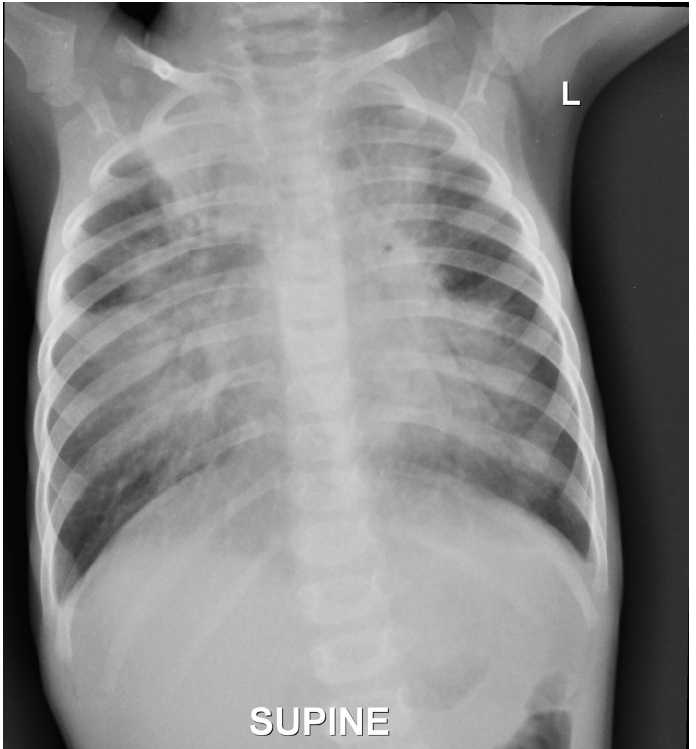
Figure 1. Chest X-ray showing extensive bronchopneumonia.